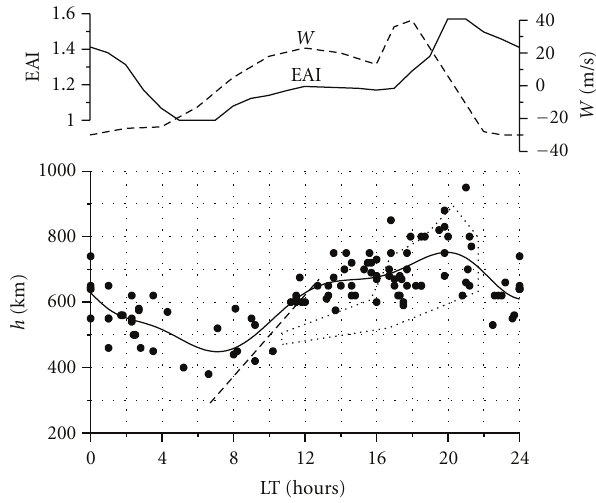
Figure 18: Bottom panel: h m F3 diurnal variation. The points show the IK-19 data, the solid line: approximation of the IK-19 data, the dashed line: virtual height of the F3 layer from ground- based ionosonde data [65]. Closed contour outlines a data array of Alouette-1 with ionization ledge occurrence according to Lockwood and Nelms [18]. Top panel: variation in vertical plasma drift velocity W over the equator [68] and the equatorial anomaly intensity